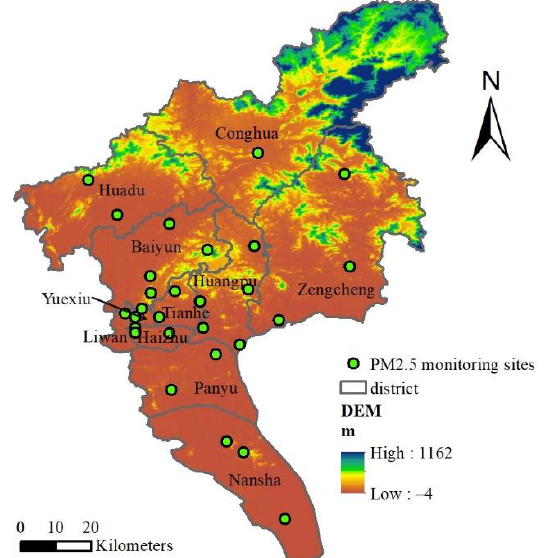
Figure 1. Spatial distribution mapping of air monitoring stations in Guangzhou.